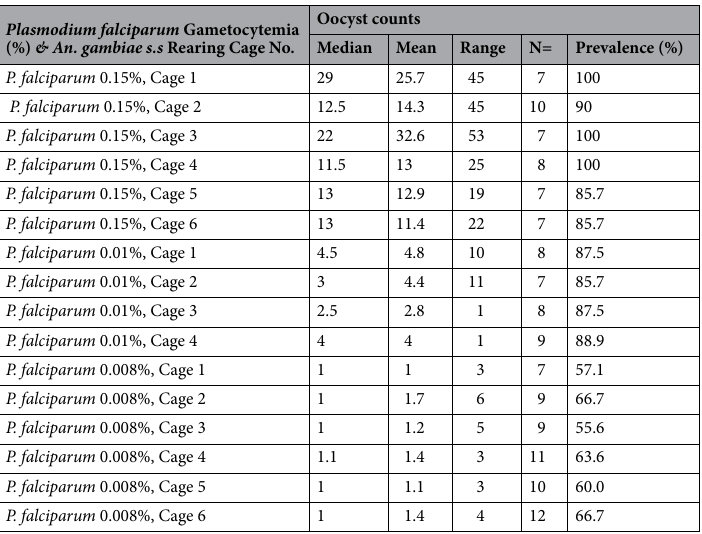
Table 1. Results from midgut oocyst counts of 8-d.o. Plasmodium falciparum infected treatment. Anopheles gambiae s.s. mosquitoes.